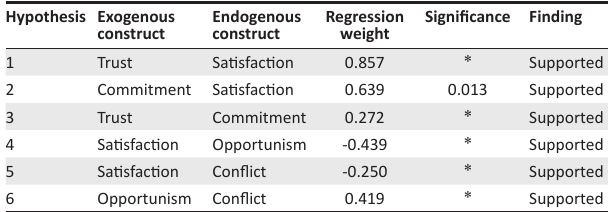
TABLE 5: Tests of hypotheses.